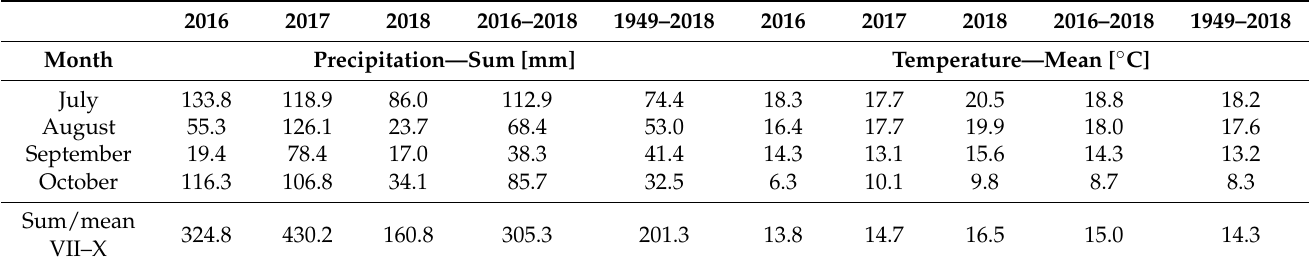
Table 1. Precipitation and air temperature (2016–2018) at the site of the field